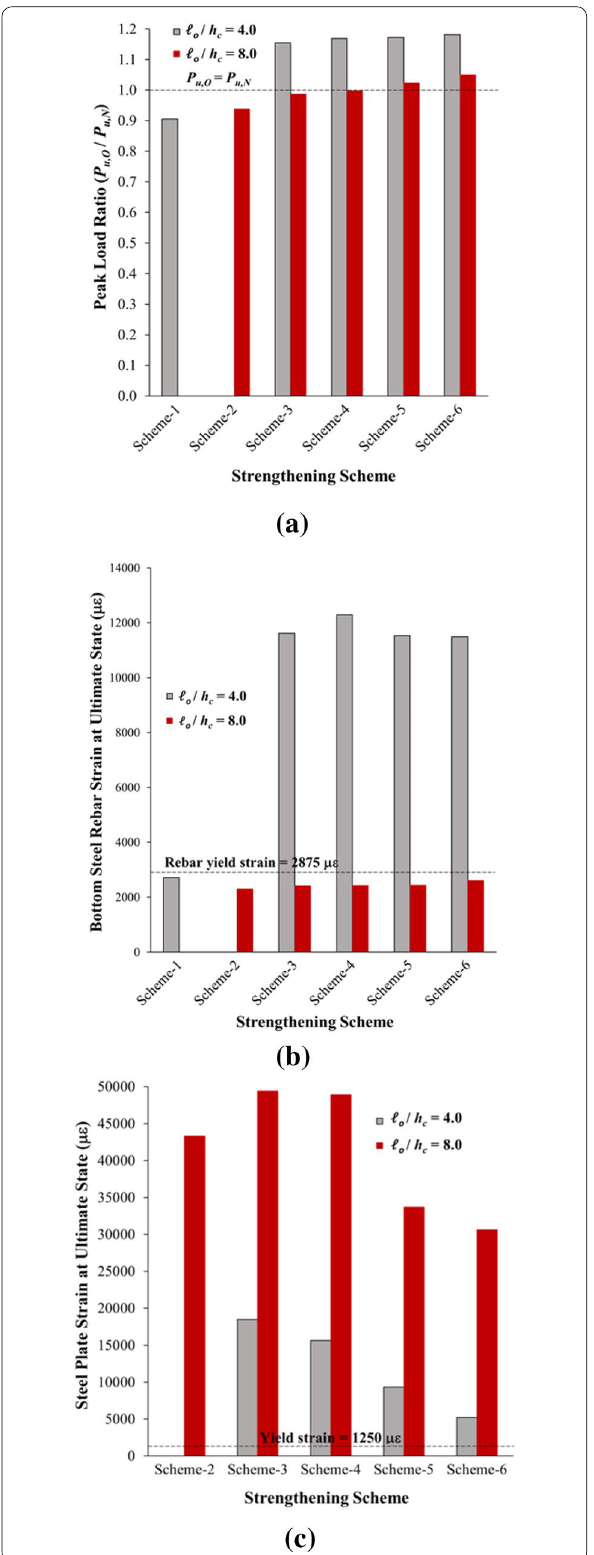
Fig. 18 Effect of strengthening scheme on performance of beams with openings and loaded at center point (based on FE analysis): a with respect to peak load, b with respect to strain of bottom steel rebars at mid‑span, and c with respect to tensile strain of steel plate at